Question: What type of chart is this?
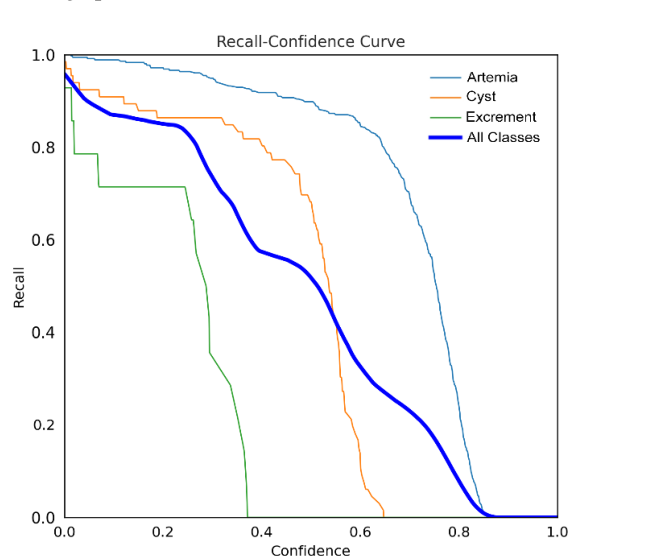
Answer: line